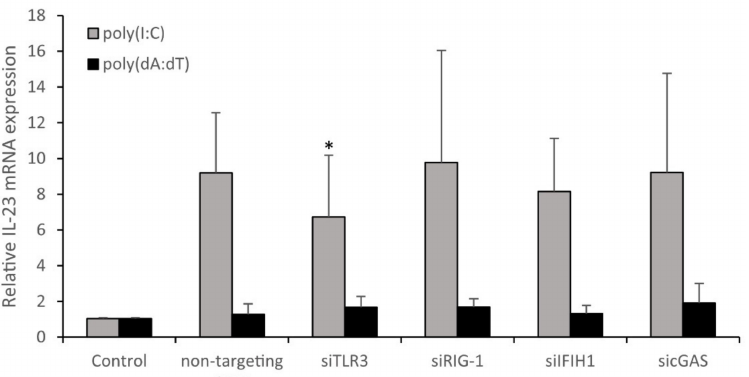
Figure 4. Silencing of the TLR3 pattern recognition receptor affects poly(I:C)-induced IL-23 mRNA ex- pression of NHEKs. Expression of pattern recognition receptors were silenced with siRNA-mediated inhibiton for 24 h, and subsequently, the cells were transfected with 0.666 µ g/mL poly(I:C) and 1 µ g/mL poly(dA:dT). Relative IL-23 mRNA expression was determined by the ∆∆ Ct method, nor- malized to GAPDH mRNA expression and compared to the expression of the non-treated control samples. Data are presented as means of four independent experiments ± SD. Significance was determined between siRNA-transfected samples and the non-targeting siRNA-transfected samples by the one-tailed, paired Student’s t -test with correction for multiple comparisons * p < 0.05.